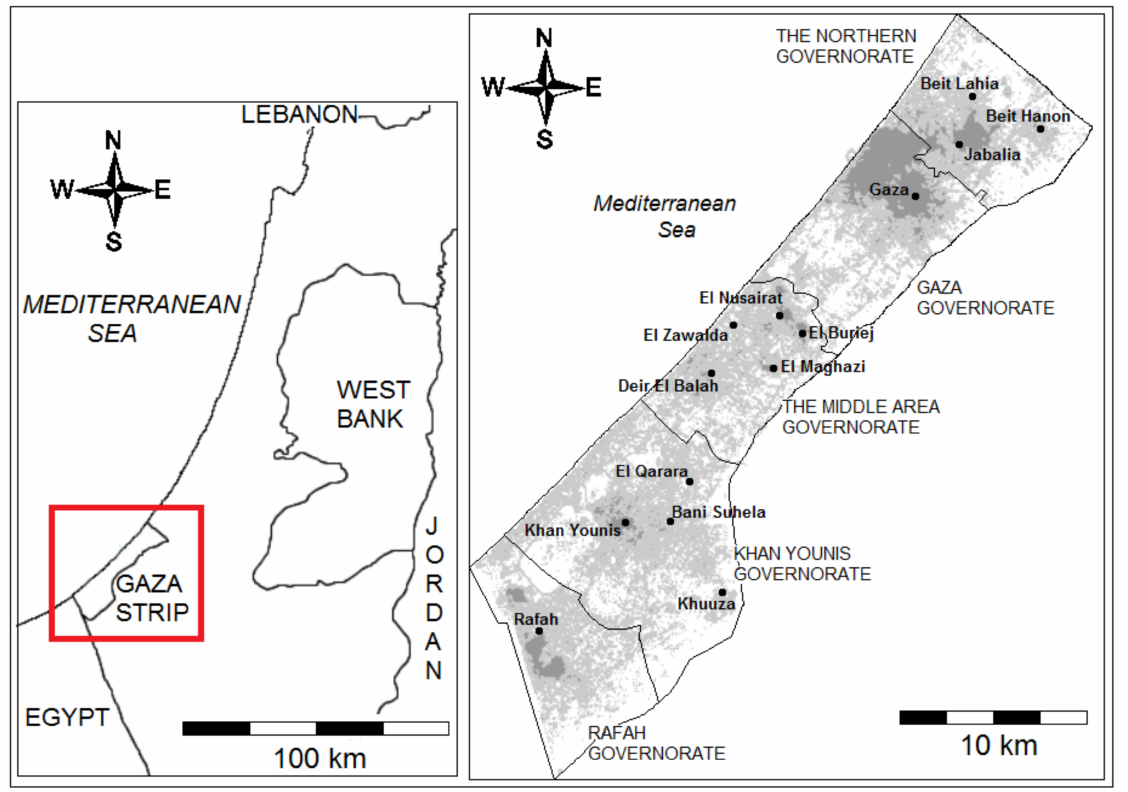
Figure 1. Location map of the Gaza Strip